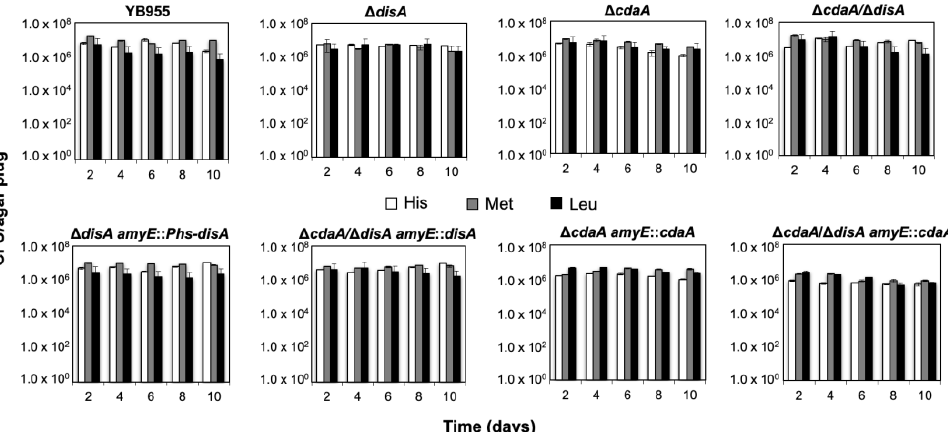
Figure 6. Determination of cell viability throughout SAM reversion assays of B. subtilis strains YB955, ∆ cdaA , ∆ disA and ∆ cdaA / ∆ disA , and of reintegrated strains ∆ cdaA amyE:: P hs-cdaA , ∆ cdaA / ∆ disA amyE:: P hs-cdaA , ∆ disA amyE:: P hs-disA and ∆ cdaA / ∆ disA amyE:: P hs-disA . Three portions of agar (plugs) were taken from free colonies sites of MM Spizizen plates, every third day, the plugs were extracted and resuspended in 1X SSMM, subjected to serial dilutions and plated on LB media to determine viable counts as described in Materials and Methods. Data represent the average CFU per plug of agar of three determinations ± standard deviations. No significant differences were found.